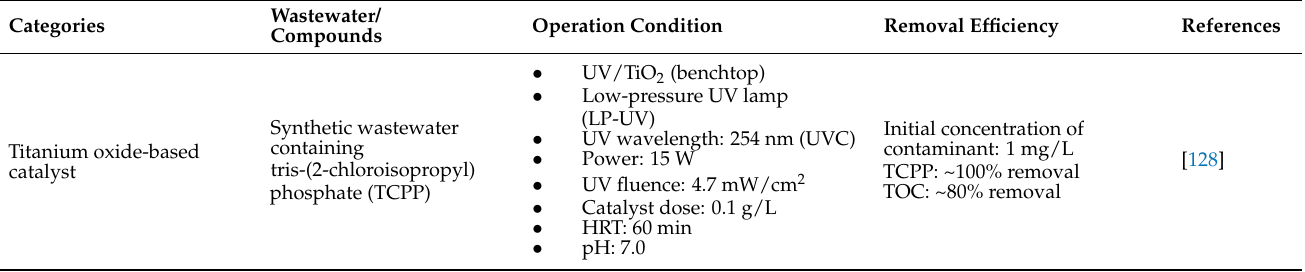
Table 7. Current application of photocatalysis